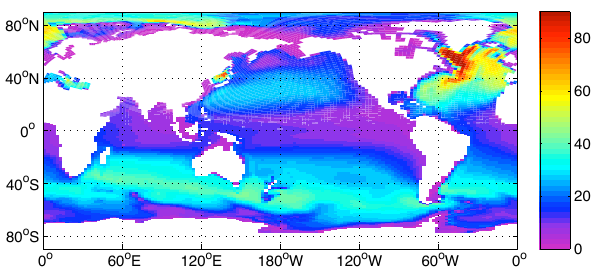
Fig. 17. Simulated column inventory of anthropogenic CO 2 in the ocean (molm − 2 ) for 1994 in the SYN+EMS experiment. The cor- relation coefficient R with the GLODAP data set (Sabine et al., 2005) is